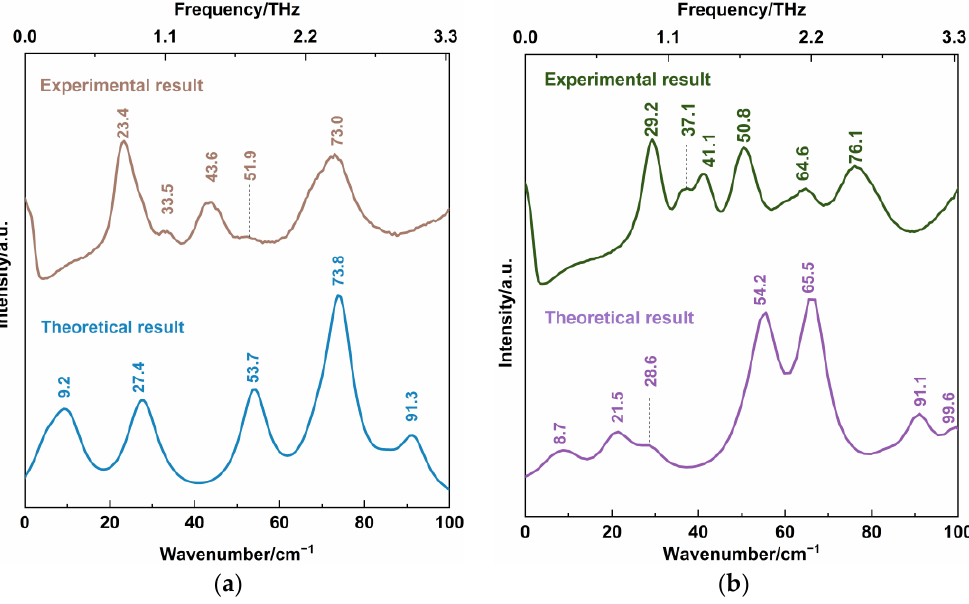
Figure 7. Comparison of low-wavenumber Raman spectra between theoretical and experimental results of ( a ) CBZ-NIC co-crystal and ( b ) CBZ-SAC co-crystals. Table 3. Vibrational mode assignment for low-wavenumber Raman characteristic peaks of the CBZ-NIC co-crystal.